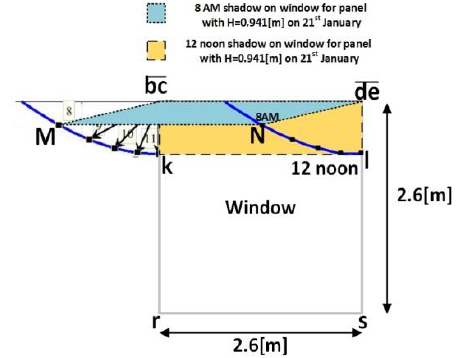
Figure 5. Shadow variation on a window on 21st January (blue lines) and at 12:00 noon (dashed lines).